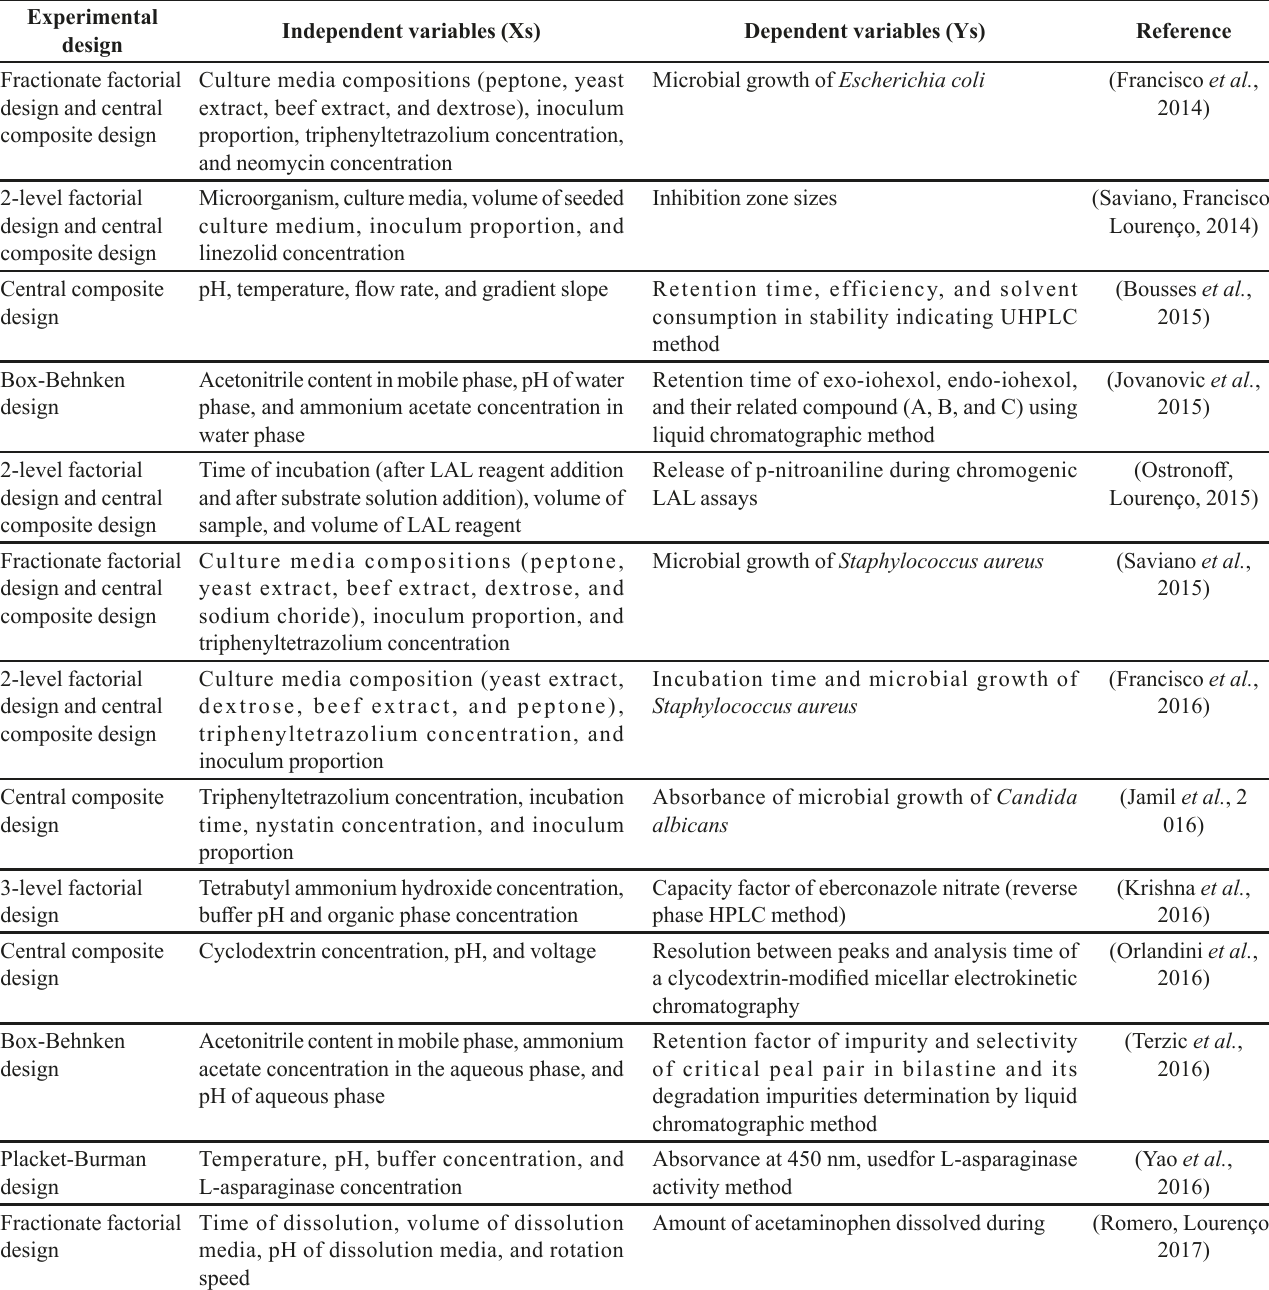
TABLE VIII – Examples of DoE applications for analytical methods development, experimental design adopted, independent variables (input factors – Xs), and dependent variables (output responses –